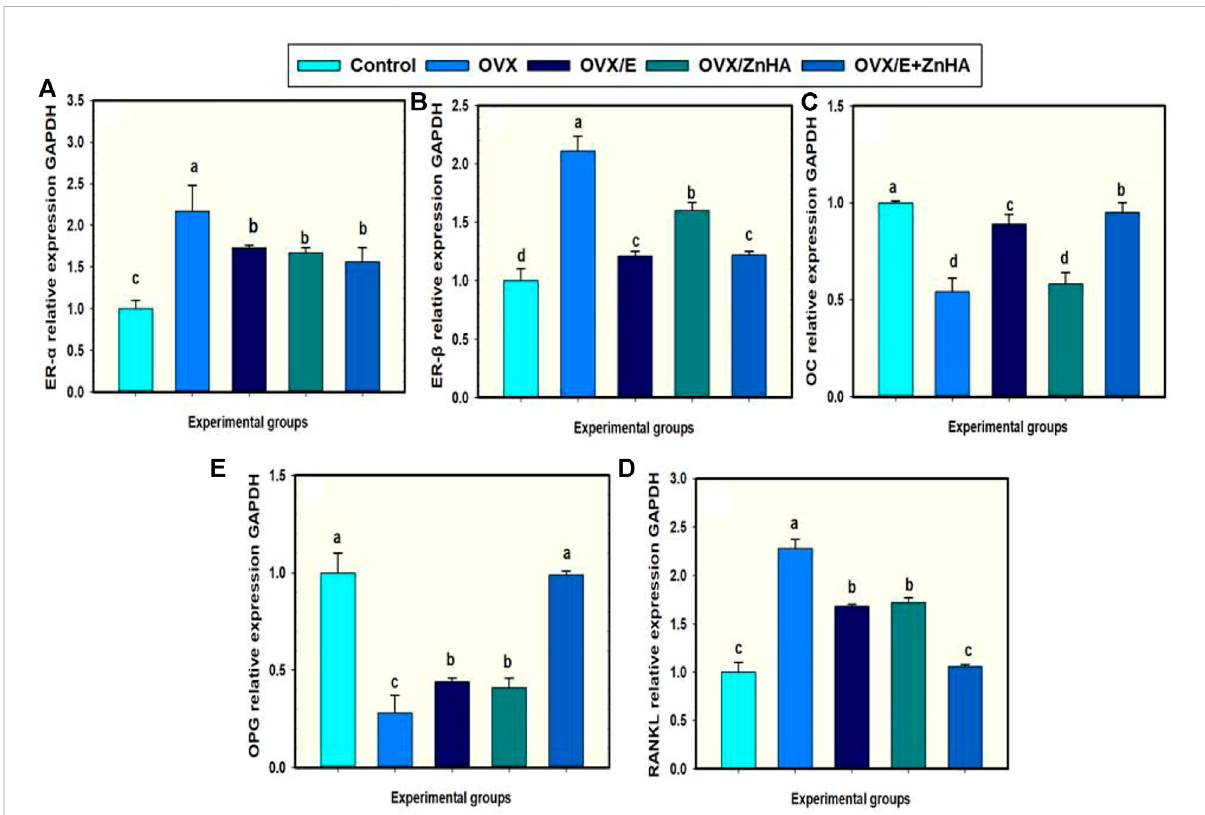
FIGURE 3 Effects of estrogen (E2) and/or zinc hydroxyapatite nanoparticles (ZnHA-NPs) on mRNA expression of femoral target genes in ovariectomized (OVX)rats.Datawereexpressedasmean±SME( n =5/group,triplicate).Barscarryingdifferentsuperscriptsaresigni fi cantlydifferent( p < 0.05).ER- α , Estrogen receptor alpha (A) ; ER- β , Estrogen receptor beta (B) ; OC, Osteocalcin (C) ; RANKL, receptor activator of nuclear factor-kappa B (NF- k B) ligand (D) ; OPG, osteoprtogrin (E)